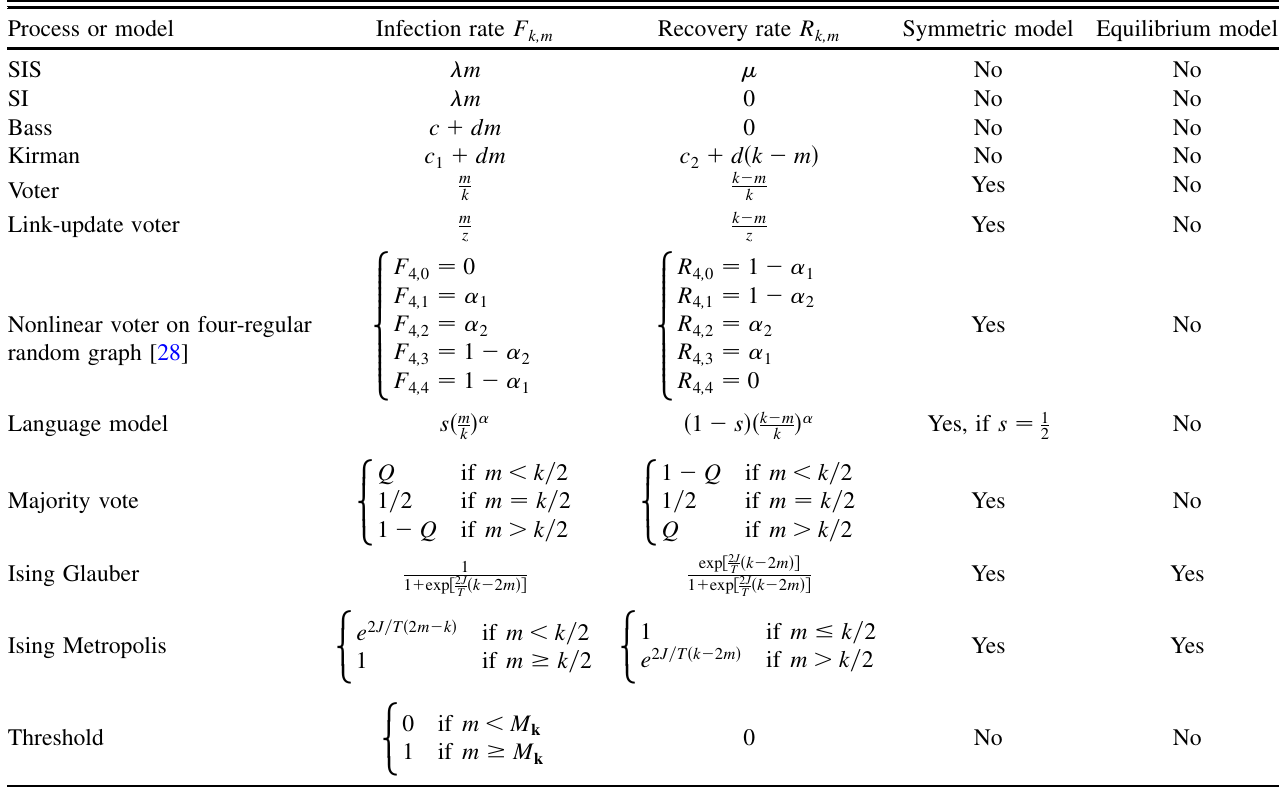
TABLE I. Infection and recovery rates for some examples of binary-state dynamics on networks: k is the node’s degree, m is its number of infected neighbors, and z is the mean degree h k i ¼ described in Sec. II. Symmetric models are those with rates that obey condition (23); equilibrium models obey condition